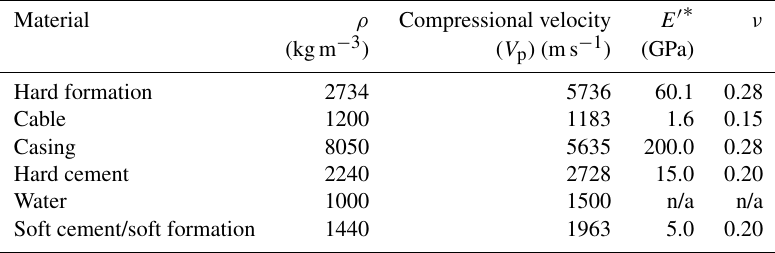
Table 3. Layer (domain) properties used for modelling.